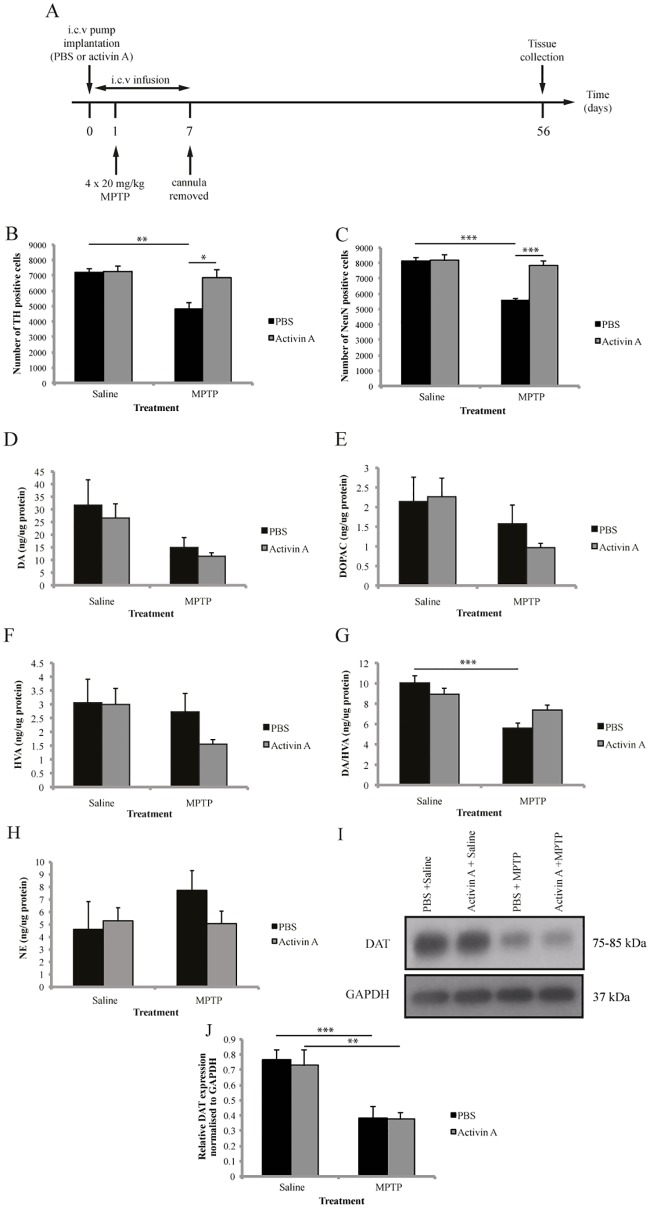
Activin A protects midbrain neurons up to 8 weeks post-MPTP.Stereological quantification demonstrates activin A protects SNpc dopaminergic neurons (A) and total neuron numbers (B) against long-term MPTP induced toxicity. No significant effect of activin A on striatal DA (C), DOPAC (D) or HVA levels (E) the turnover of DA to HVA (F) or striatal NE levels (G) was found 8 weeks post-MPTP. (H) Representative images of DAT and GAPDH expression. (I) Western blot analysis of striatal protein extracts revealed activin A does not protect DAT expression 8 weeks post-MPTP. All values represent the mean ± SEM. *p<0.05 **p<0.01, ***p<0.001. N = 3-13/group.